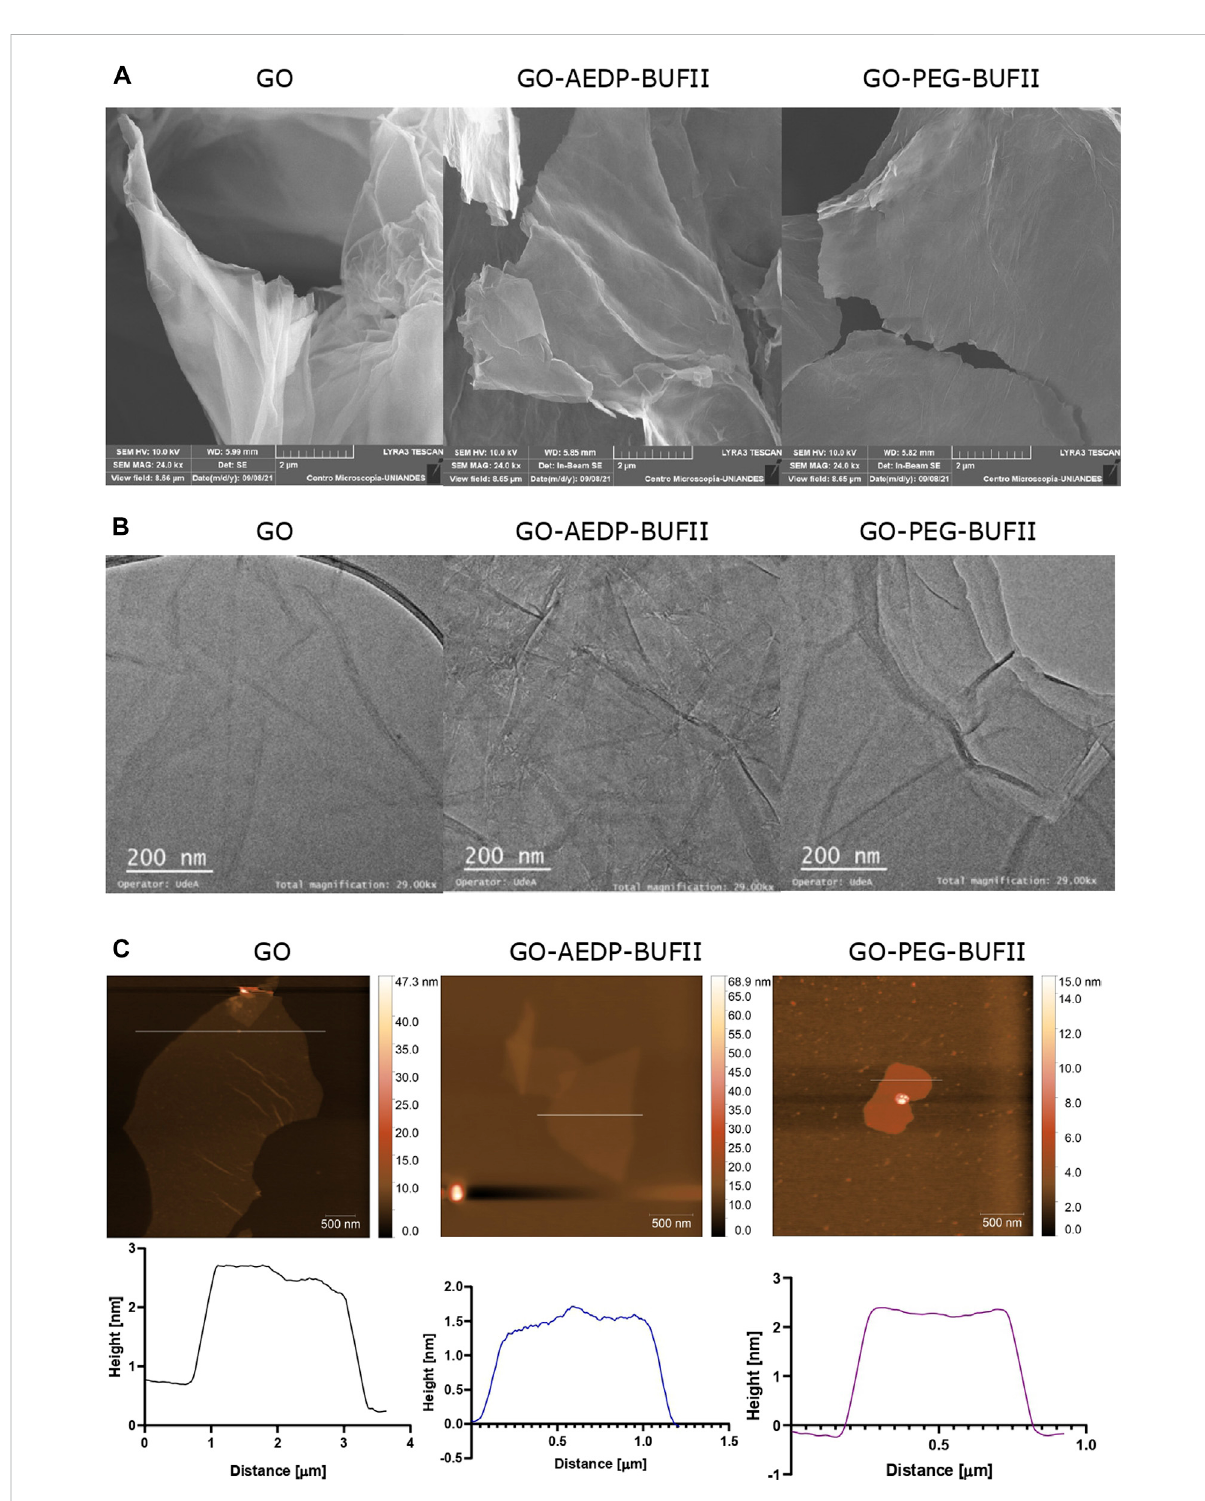
FIGURE 3 Microscopic characterization of the developed nanostructures via (A) SEM imaging; (B) TEM imaging; (C) AFM imaging, and height pro fi